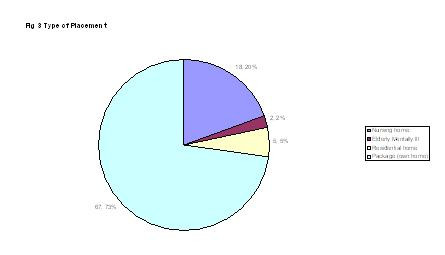
Types of community placement required.